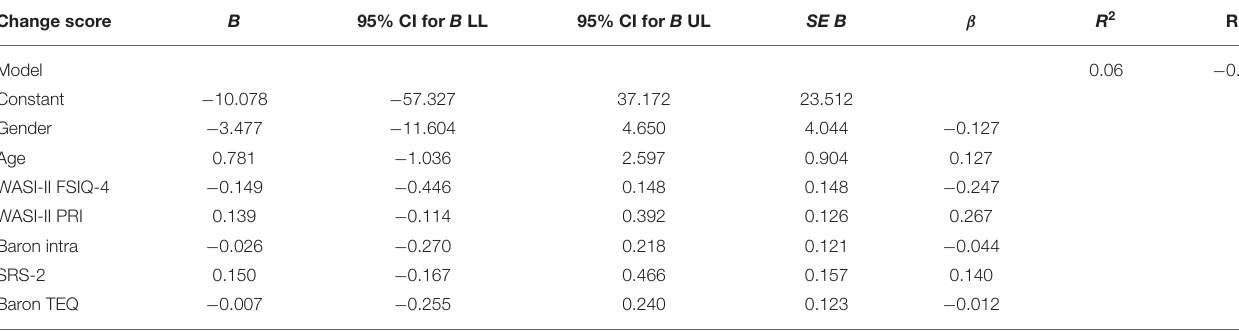
TABLE 3 | Multiple regression results for parent change